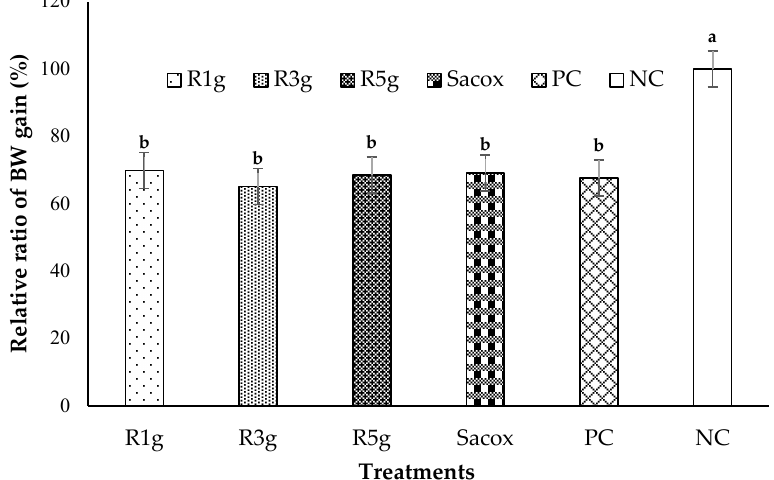
Figure 5. Effect of experimental treatments and infection with E. tenella on the relative ratio of body weight gain of birds at 7 d postinoculation. (R1g, R3g, and R5g represent 2, 4, and 6 g RN/kg diet, respectively, Sacox: 66 mg salinomycin/kg diet, PC and NC: basal diet with and without coccidiosis challenge, respectively. Different lowercase letters indicate significant differences.